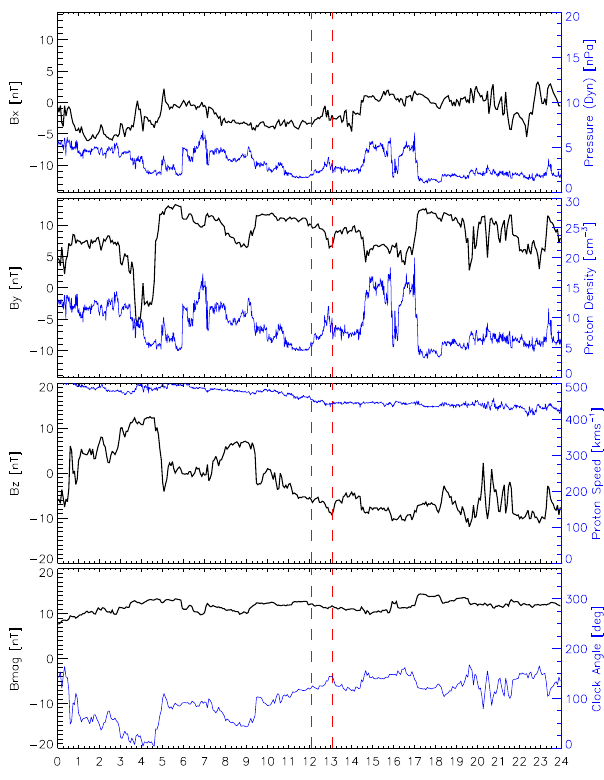
Fig. 10. ACE solar wind parameters showing several hours either side of 12:04–13:05 UT.